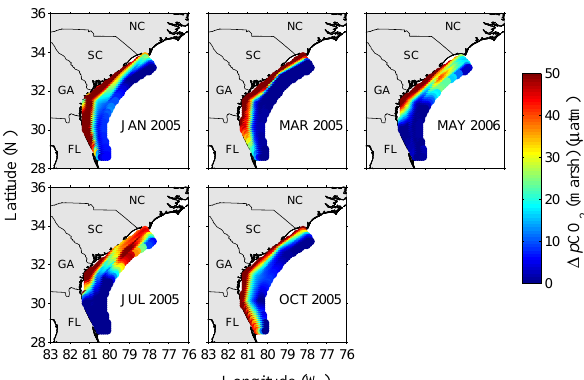
Fig. 9. Spatial distributions of 1p CO 2 (marsh) (referenced to 23.11 ◦ C). Due to a lack of DIC data, 1p CO 2 (marsh) in December 2005 is not presented. The colored contours are from triangle-based liner